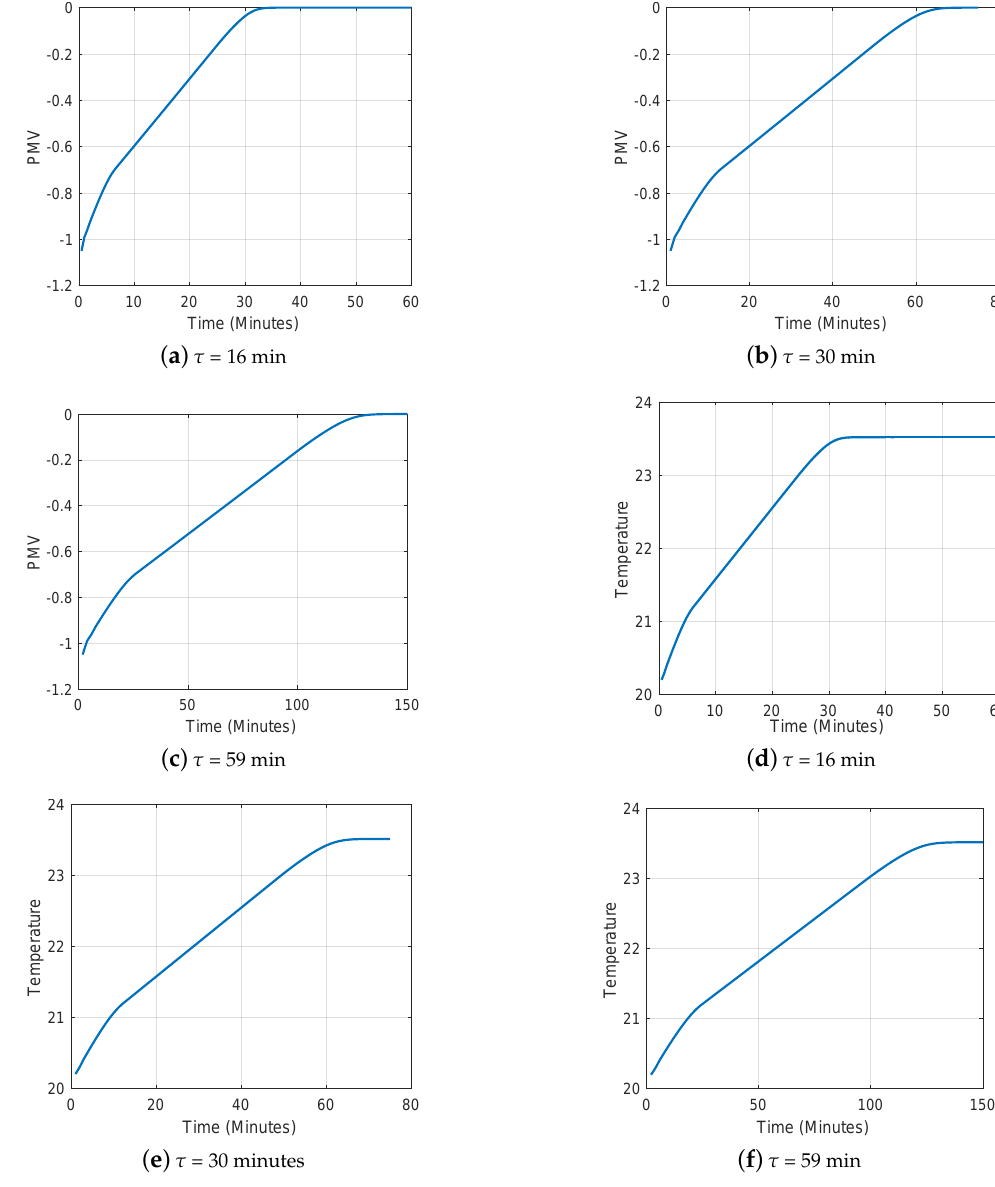
Figure 5. Illustration of the results of different comfort time constants for the proposed thermal control system with an initial temperature of 20 ◦ C changing to a sitting position for both the PMV and temperature of a room. Top: PMV values; and Bottom: Temperatures as functions of different comfort time